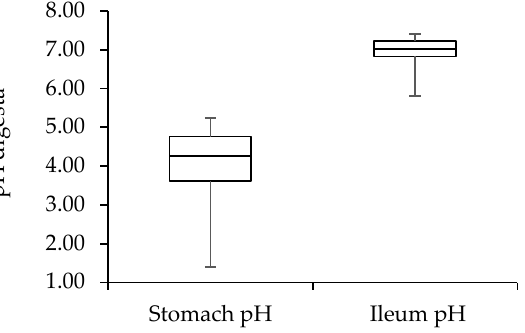
Figure 2. Box plots representing individual variation in digesta pH of the stomach and the ileum 4 h after the piglet’s last meal. Piglets were ± 47 days of age (3 weeks post-weaning). Average stomach pH was 4.04 (SD = 0.991) and average ileal pH was 7.03 (SD = 0.323). The data represent 213 individual piglets that were fed one of 31 experimental diets containing protein-rich feedstuffs (6–8 piglets/experimental treatment; between 2017 and 2020 at Schothorst Feed Research B.V., Lelystad, The Netherlands). The pH of the stomach was measured in the stomach content after thorough mixing. Ileal digesta were taken from the last 2 m of the small intestine and mixed before measuring the pH value.